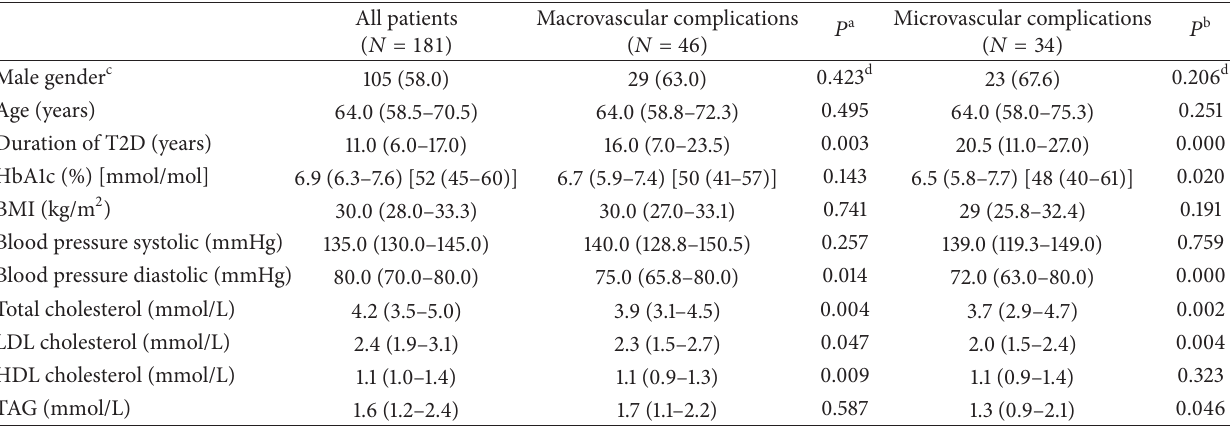
Table 1: Patients characteristics.